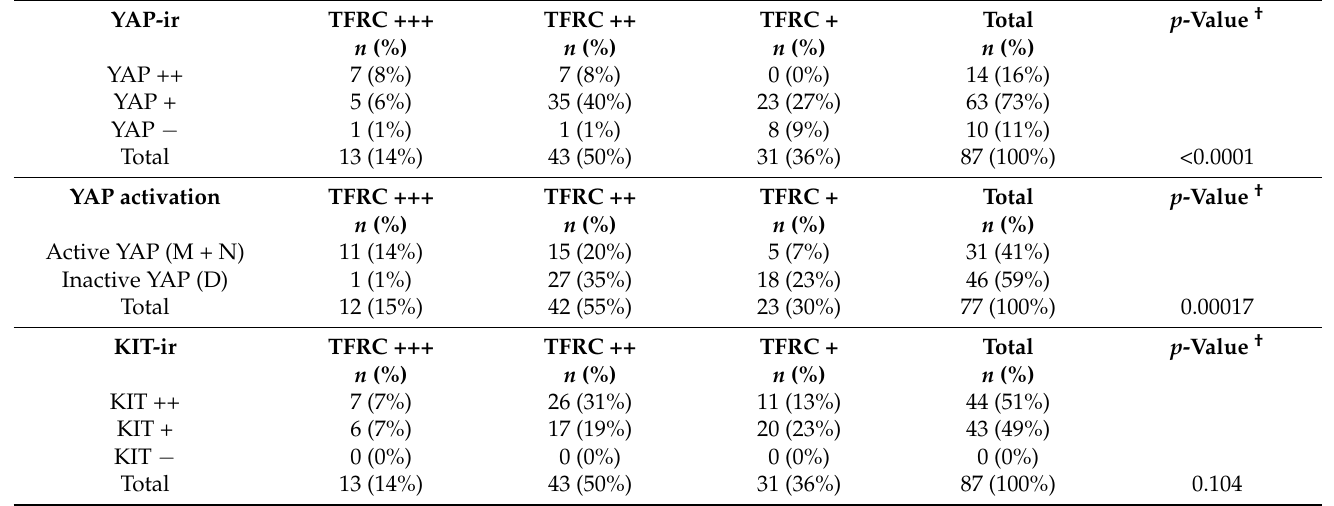
Table 2. The association of TFRC-ir with YAP-ir, KIT-ir, and YAP activation in 87 GIST